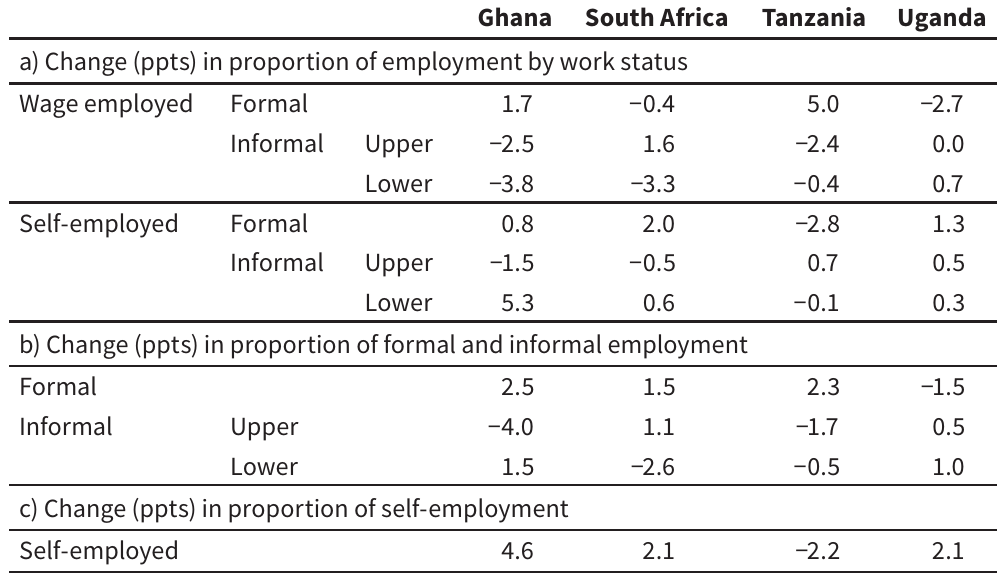
Change in distribution of workers by work status, balanced panel Ghana South Africa Tanzania